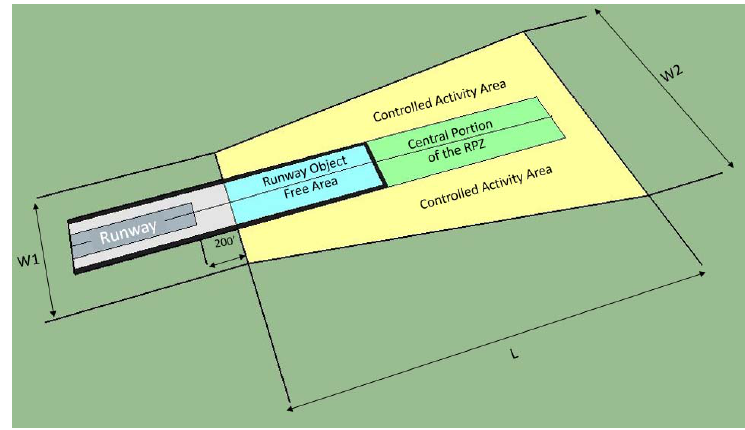
Figure 2. Surface areas with and near the end of a runway [39], which cannot be used for PV deployment. Only surface areas coated in green can be used for PV.